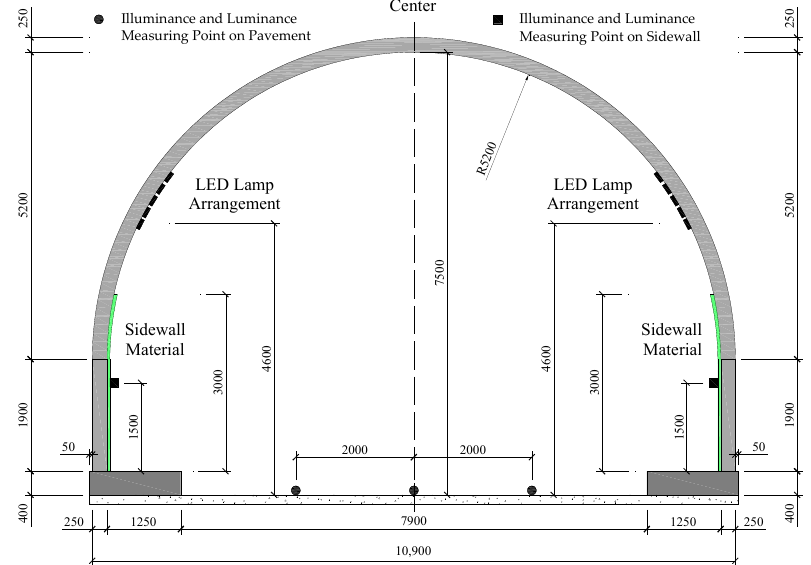
Figure 1. Dimensions of tunnel cross ‐ section (Unit: mm).